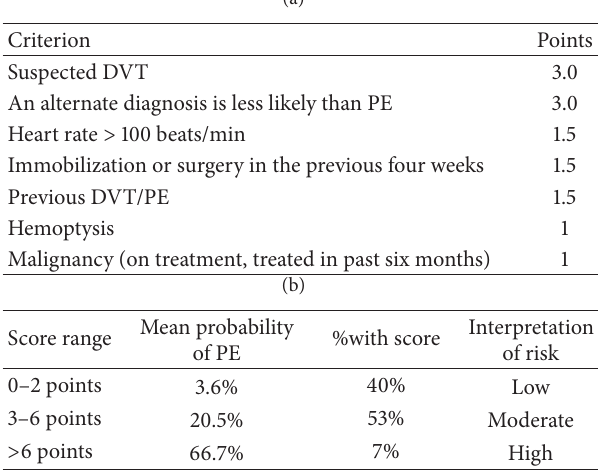
Table 1: The Wells criteria for assessment of pretest probability of pulmonary